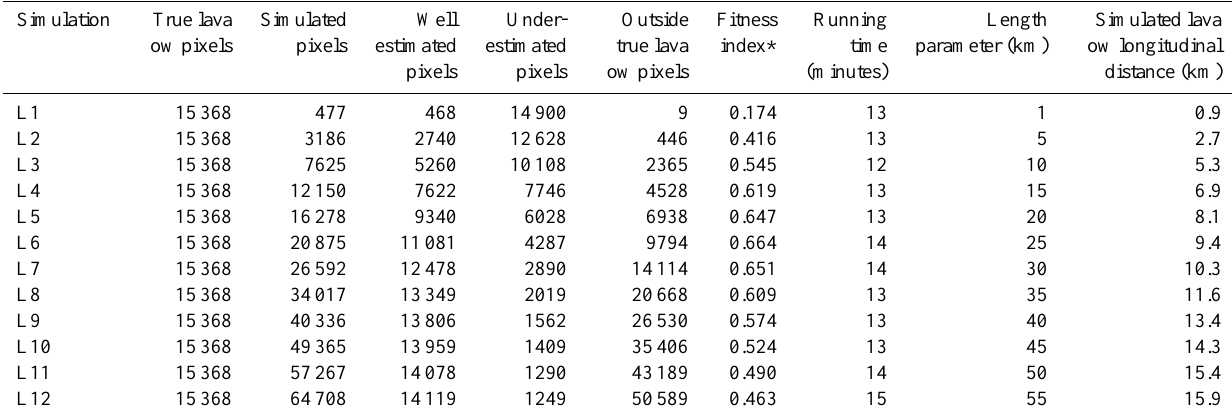
L10 15368 13959 1409 L11 15368 57267 14078 1290 43189 0.490 14 50 15.4 L12 15368 64708 14119 1249 50589 0.463 15.9